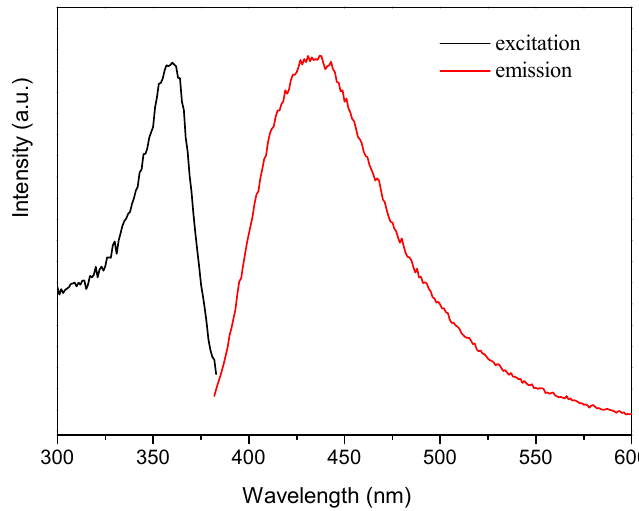
Figure 10. Solid-state photoluminescent spectra of 1 at room temperature.